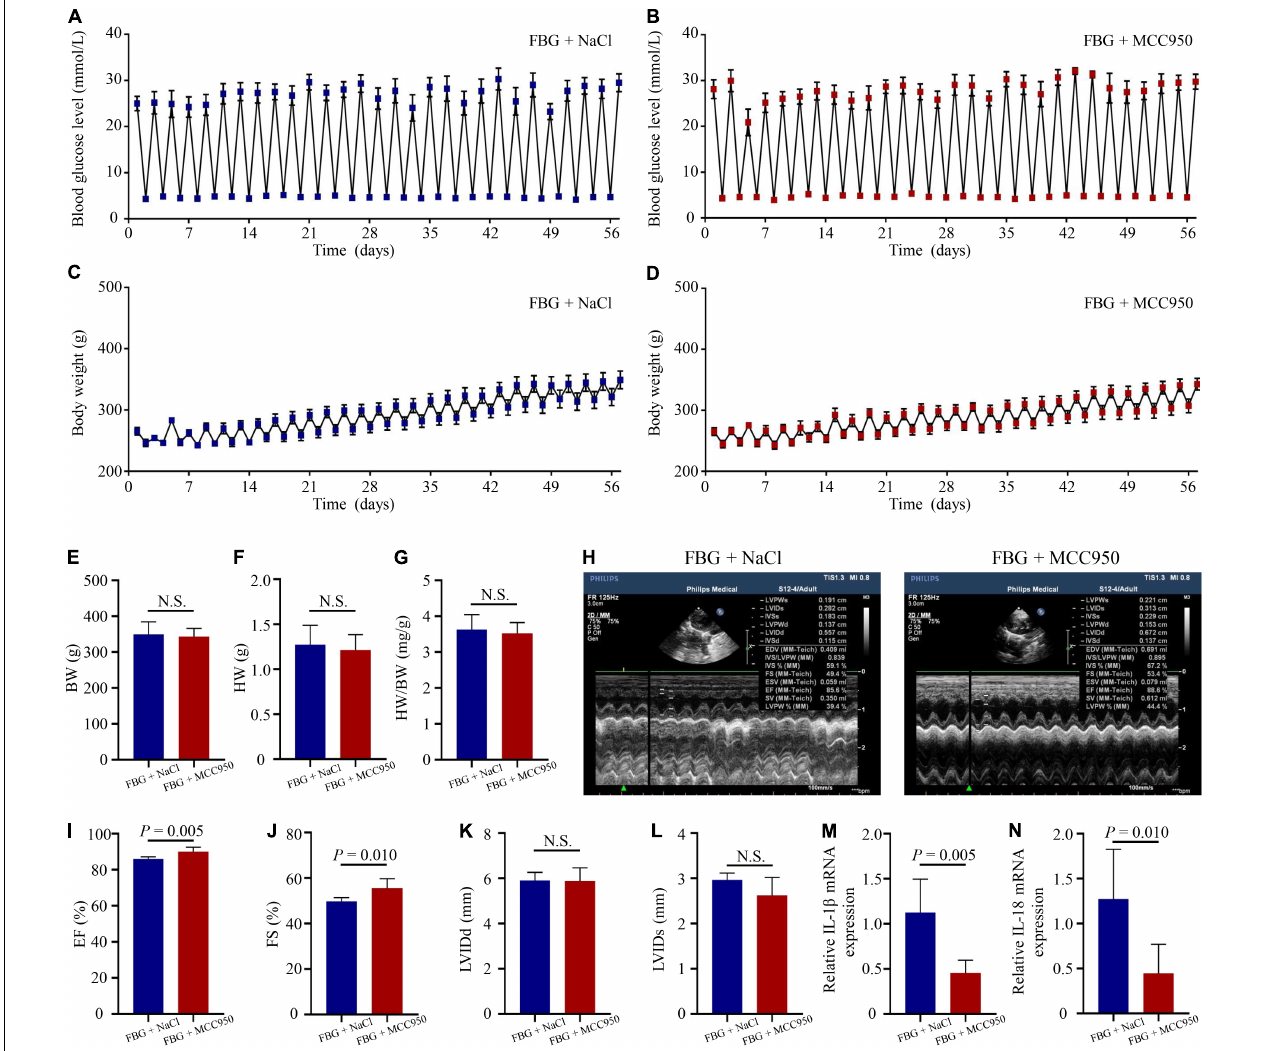
FIGURE 6 | NLRP3 inhibition with MCC950 reversed rat left ventricular systolic dysfunction induced by glucose fluctuations. (A,B) Levels of blood glucose in the FBG + NaCl and FBG + MCC950 groups ( n = 6 per group). (C,D) Body weights in the FBG + NaCl and FBG + MCC950 groups ( n = 6 per group). (E–G) Body weights, heart weights and heart weight/body weight ratios of rats in the FBG + NaCl and FBG + MCC950 groups ( n = 6 per group). (H–L) Representative echocardiographic images of rats, LVEF (%), LVFS (%), LVIDd and LVIDs in the FBG + NaCl and FBG + MCC950 groups ( n = 6 per group). (M,N) Relative mRNA levels of IL-1 β and IL-18 in the FBG + NaCl and FBG + MCC950 groups ( n = 6 per group). N.S.: No